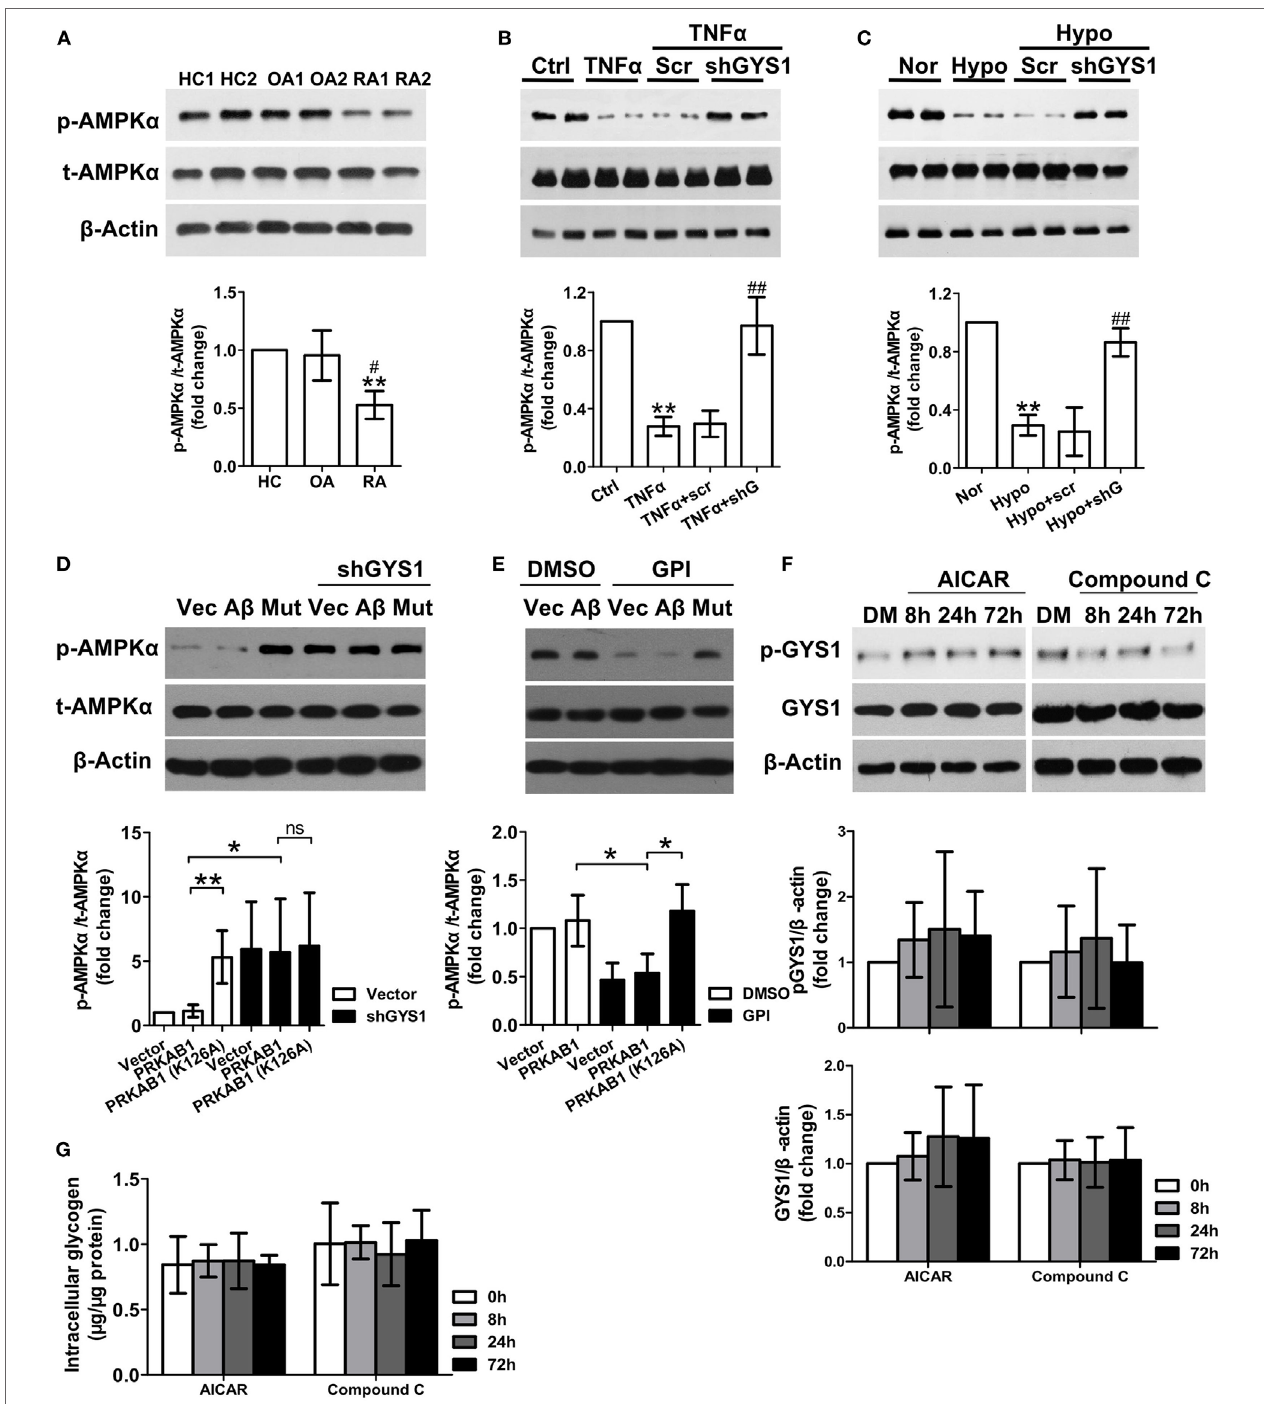
FigUre 3 | Effect of glycogen synthase 1 (GYS1) knockdown on AMP-activated protein kinase (AMPK) activity in rheumatoid arthritis (RA) fibroblast-like synoviocytes (FLSs). (a) AMPK activity in FLSs from healthy control (HC) ( n = 5) and patients with osteoarthritis (OA) ( n = 5) and RA ( n = 9). Representative images of immune blots are shown (upper panel), and data from densitometric quantification (lower panel) are expressed as the mean ± SD. (B,c) Effect of GYS1 knockdown on AMPK activation induced by TNF- α (B) or hypoxia (c) . Transfected FLSs were untreated or treated with TNF- α (10 ng/ml) or cultured under normoxic (nor, 21% O 2 ) or hypoxic conditions (hypo, 1% O 2 ) for 24 h. The data represent the densitometric quantification (mean ± SD, lower panel) of four independent experiments. (D) Effect of AMPK β 1 (A β ) and AMPK β 1 mutation (Mut) on AMPK activation induced by GYS1 knockdown (D) and glycogen phosphorylase inhibitor (GPI) (e) . (F,g) Effect of the AMPK agonist AICAR (AI) or inhibitor Compound C (Co) on phosphorylated and total GYS1 expression (F) and glycogen level (g) in RA FLSs at different time point. RA FLS were treated with AICAR (1 mM), Compound C (Co) (1 µM) or DMSO (DM) for different times (8, 24, and 72 h). The data are presented as the mean ± SD of four independent experiments. * P < 0.05 vs. HC or nor or control; # P < 0.05 vs. OA or TNF- α + scr or hypo +